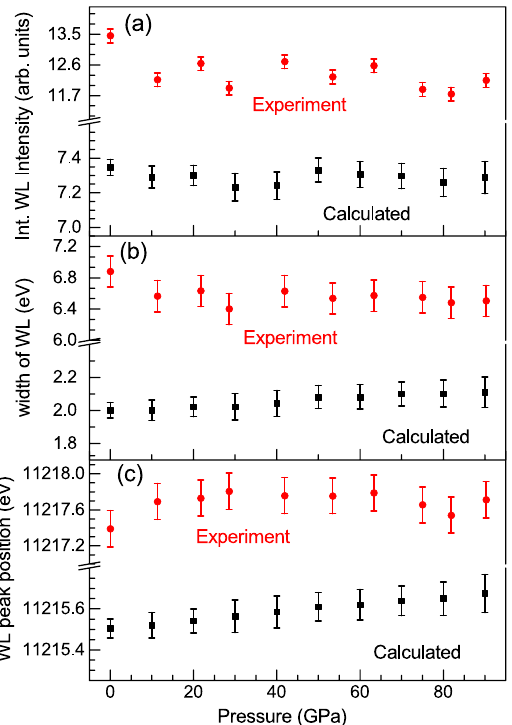
Figure 6. ( a ) Integrated intensity of WL of the XAS spectra collected at Ir L 3 edge under pressure is represented, ( b ) the pressure evolution of the linewidth of the WL is plotted and ( c ) the variation of WL peak position under pressure is shown. Red points correspond to experimental data and black points correspond to simulated data using WIEN2k